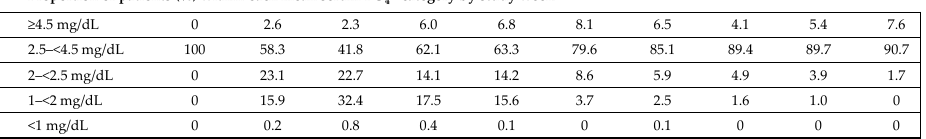
Figure 2. Shift in mean serum PO 43 − by study week among subjects with normal PO 43 − values at baseline. Included subjects had baseline PO 43 − measurements and values 2.5– < 4.5 mg / dL ( n = 5489). Subject numbers are indicated for each time point. Bars and tables depict patients with mean serum PO 43 − values within each HP range category, as a percentage of all evaluable patients for each study week. HP, hypophosphataemia; PO 43 − , phosphate. Table 2. Mean serum PO 43 − shift from baseline at study Week 8. The numbers of subjects falling within serum PO 43 − categories at Week 8 are shown by baseline PO 43 − values. A total of 2371 subjects with baseline measurements had serum PO 43 − values available at Week 8. “Total” column shows the proportion of subjects in each PO 43 − value category as a proportion of all available subjects. Grey shaded cells demonstrate subjects with mean serum PO 43 − values ≥ 2.5 mg / dL at Week 8 (2112 / 2371 [89.1%]). < Baseline